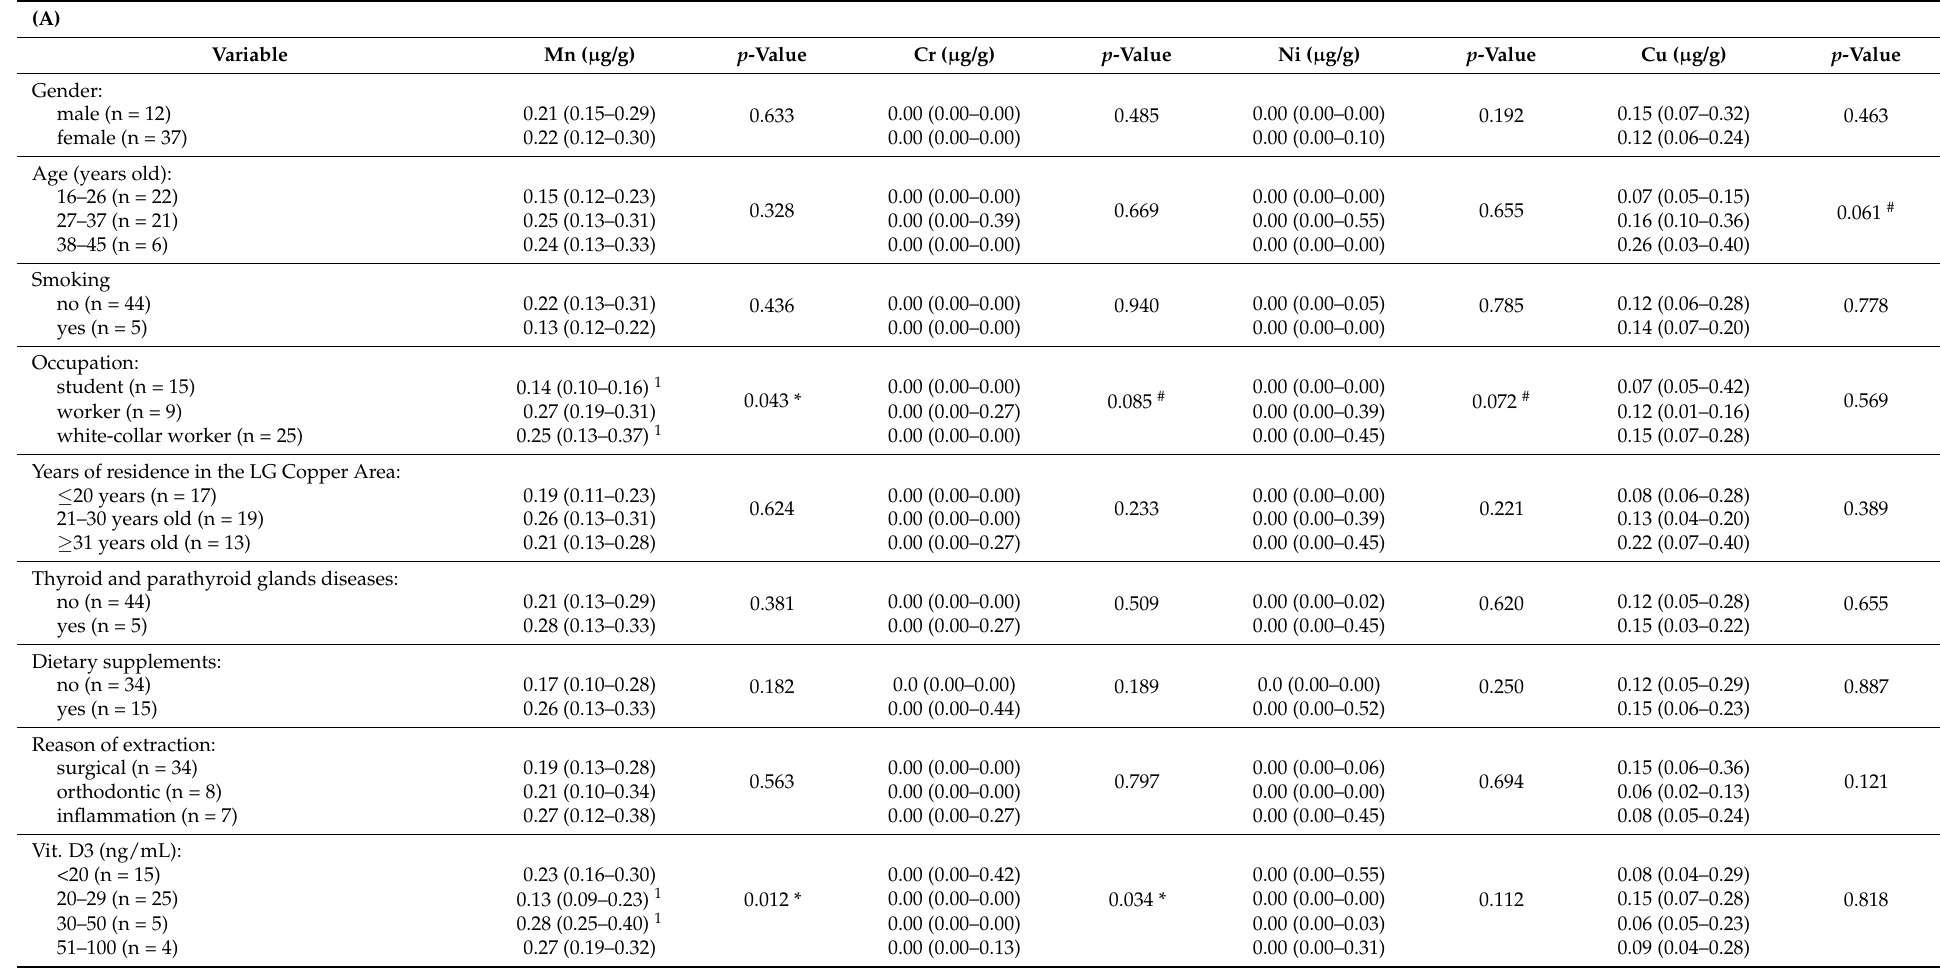
Table 4. A. Risk factors determining the accumulation of Mn, Cr, Ni, Cu in the teeth of patients residing in the LG Copper Area ( n = 49). B. Risk factors determining the accumulation of Fe, Cd, Pb, Zn in the teeth of patients residing in the LG district ( n = 49). Descriptive data are presented as median (Q1–Q3). Mann–Whitney test or Kruskal–Wallis analyses are used for analysis of differences between two or more than two categories of